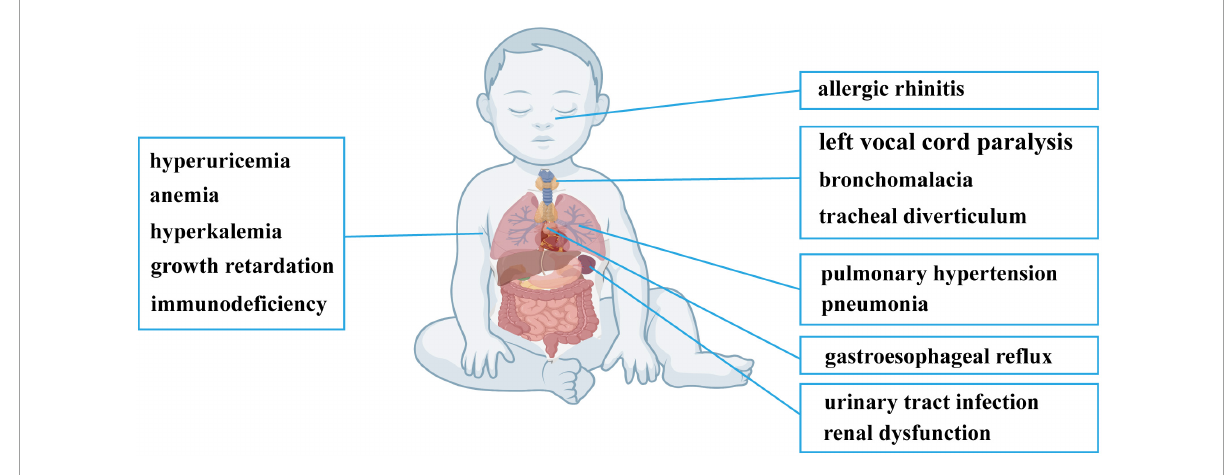
FIGURE1 Clinical findings of the patient with HUPRA